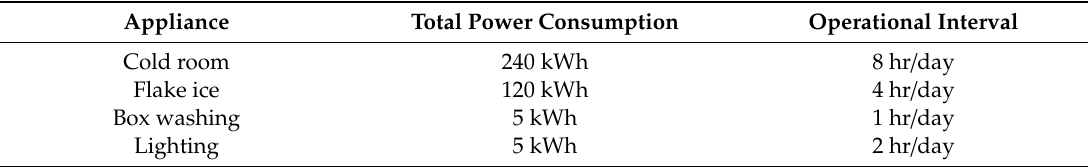
Table 3. The appliance usage list in the Packaway